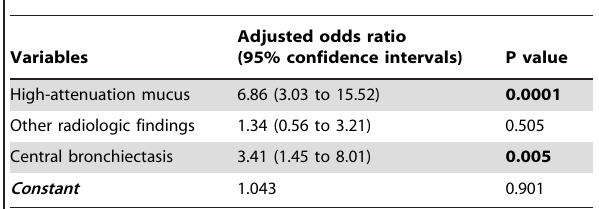
Table 5. Effects of HRCT findings (HAM, number of bronchiectatic segments and ORF) on occurrence of frequent relapses - multivariate logistic regression model.